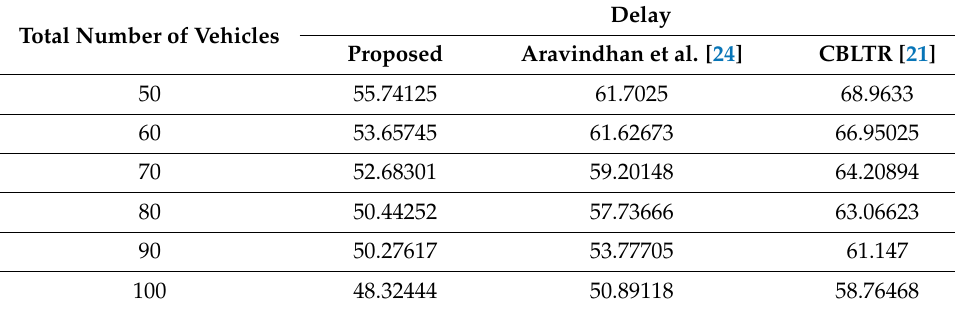
Table 7. Delay versus vehicular nodes in area (1000 × 1000).